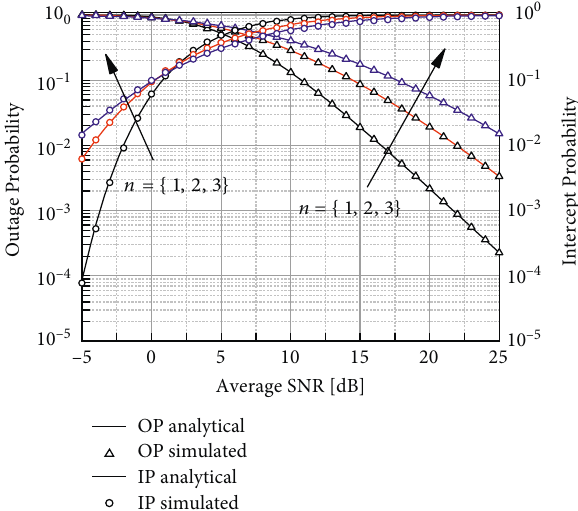
Figure 2: OP and IP versus average SNR for various values of n .